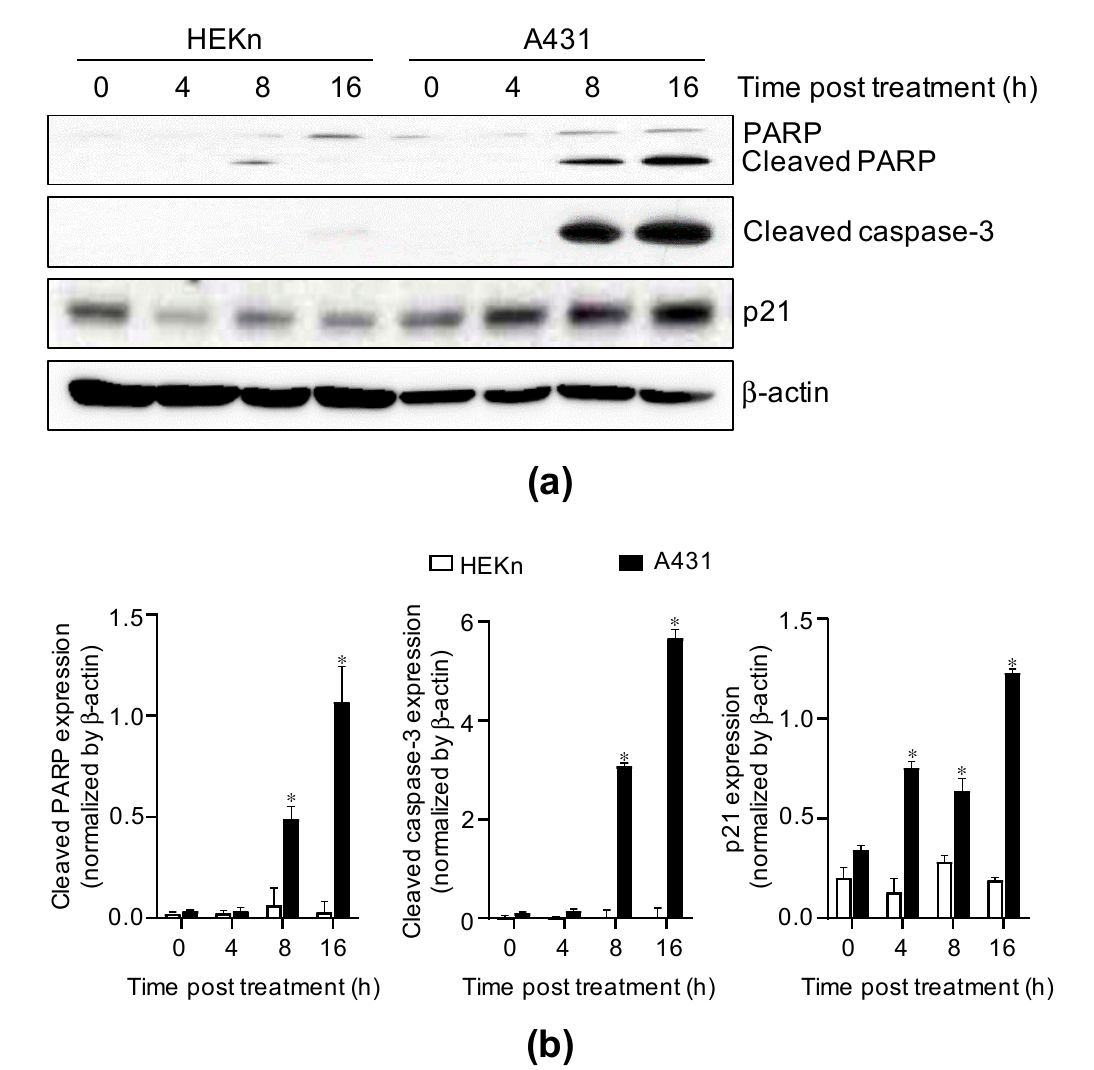
Figure 4. Effect of costunolide on caspase-3 activation and PARP cleavage in HEKn cells and A431 cells. HEKn cells and A431 cells were treated with costunolide (0.8 µ M) at various time points (0, 4, 8, and 16 h). Whole cell lysates were harvested. ( a ) Protein levels of PARP, cleaved PARP, cleaved caspase-3, and p21 were evaluated by western blotting. β -actin was used as the loading control. ( b ) Bar graphs display quantification of protein levels normalized by β -actin. * p < 0.05 as compared to vehicle-treated group.